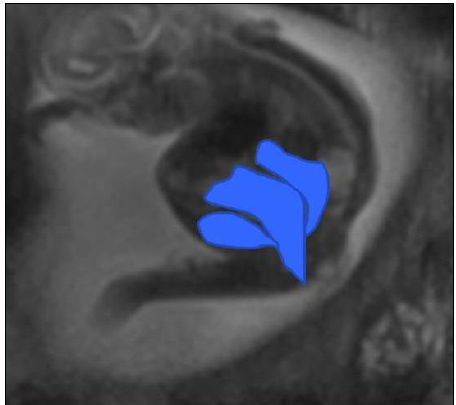
Figure 4: Fetal MRI of a 22 week fetus with a cloaca, and the bladder, vagina and rectum are highlighted in